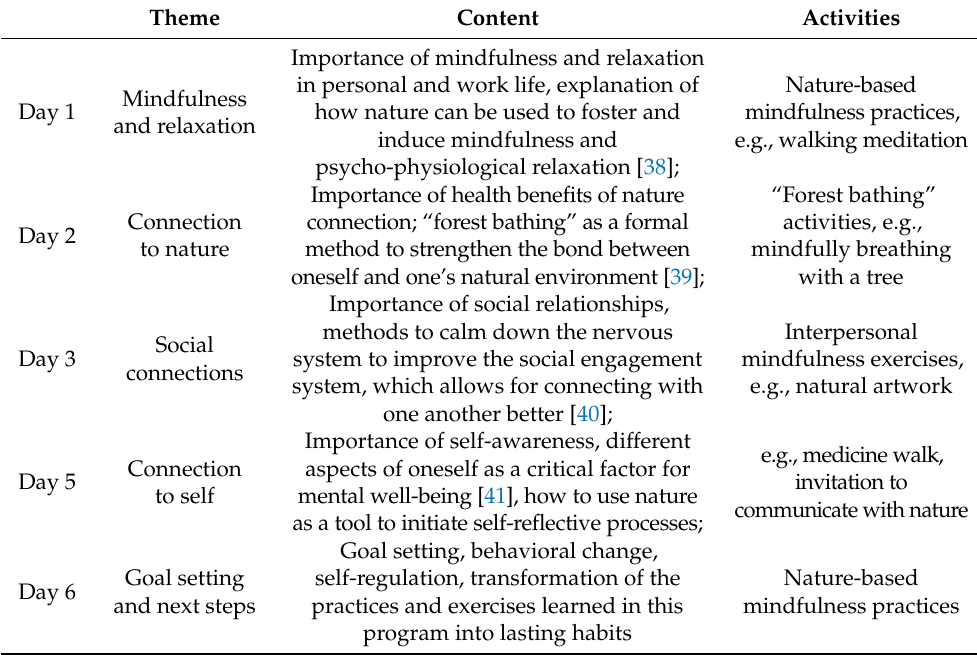
Table 2. Thematic schedule of the nature group.